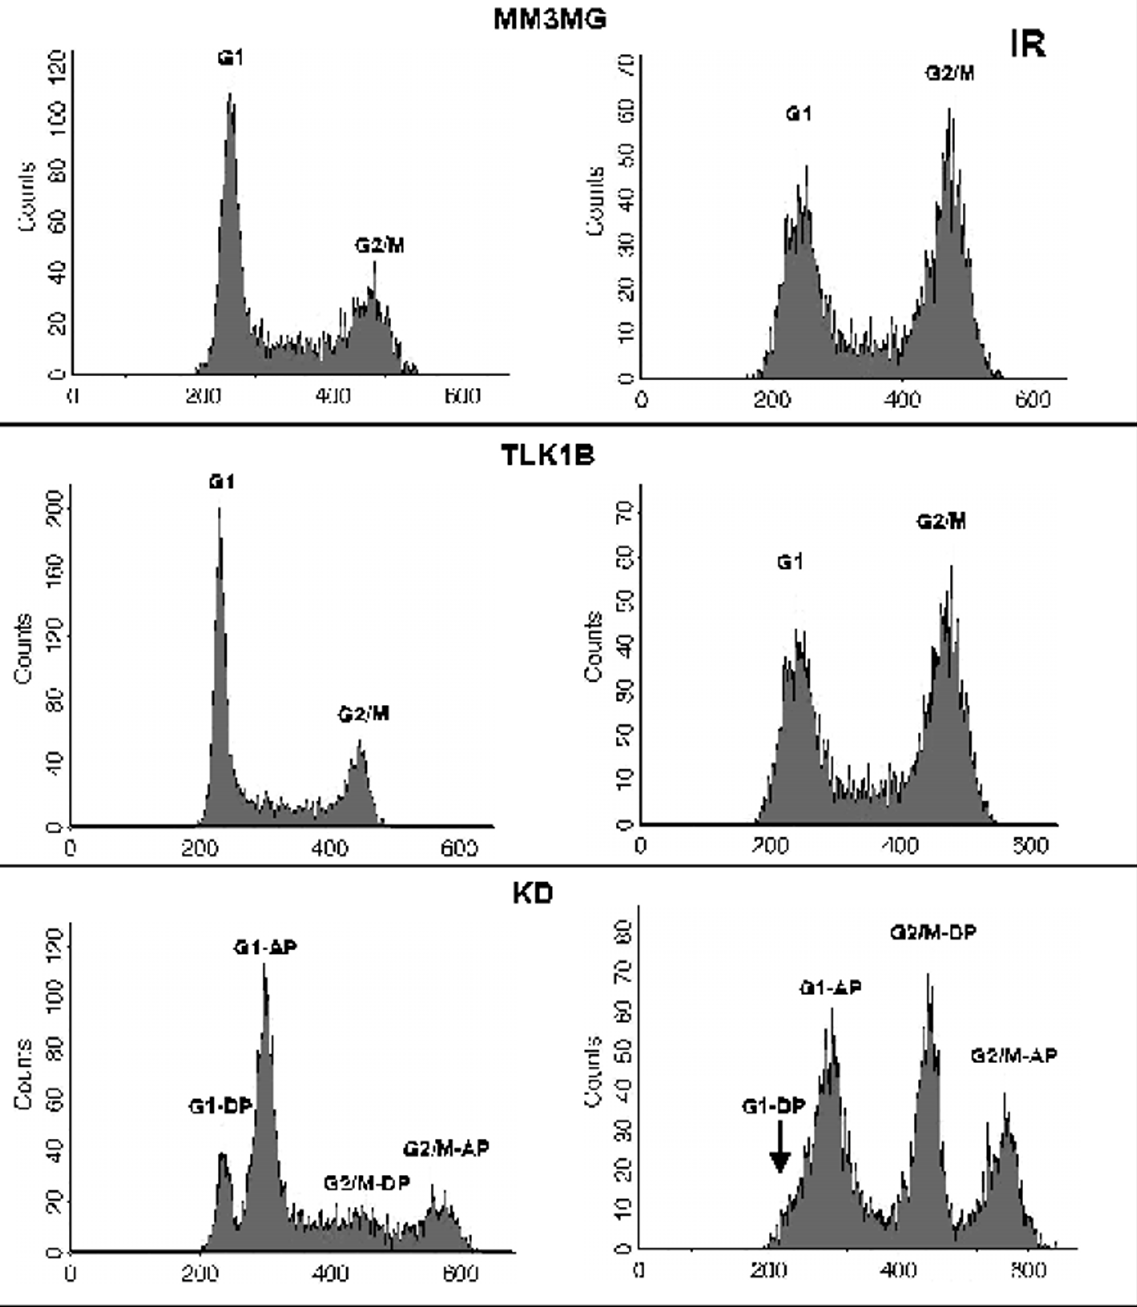
Figure 2 Overexpression of TK1B-KD affects the ploidy of MM3MG cells. The cell cycle distribution of the indicated lines was analyzed by PI staining and FACS. The right panels show cells 24 h after treatment with 10 Gy of